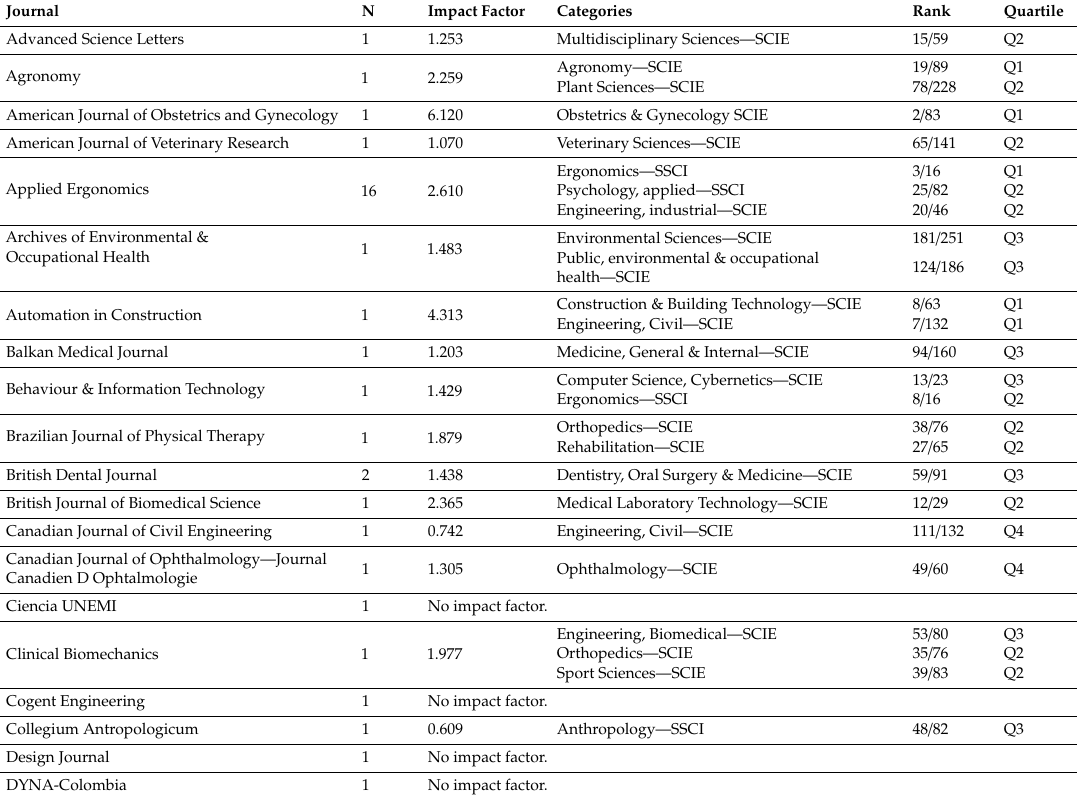
Table 22. Number of publications (N) by scientific journal, knowledge categories (Web of Science), impact factor, rank and quartile